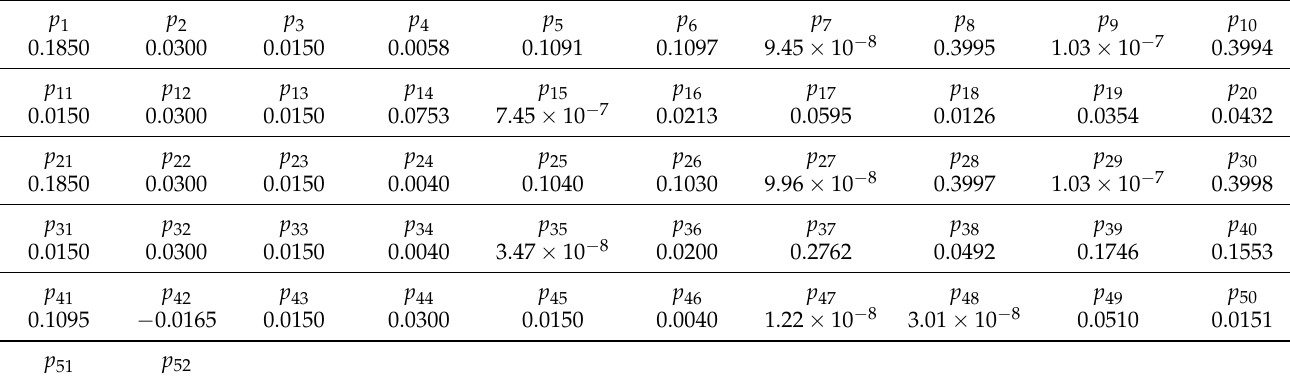
Table 3. The design variable vector (elite solution) included in the initial